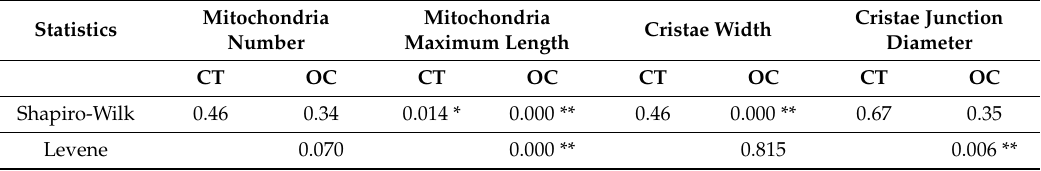
Table 2. Probabilities associated with Shapiro-Wilk and Levene’s tests for mitochondria number, maximum length, cristae width, and cristae junction diameter in controls (CT) and ovarian cancer (OC).